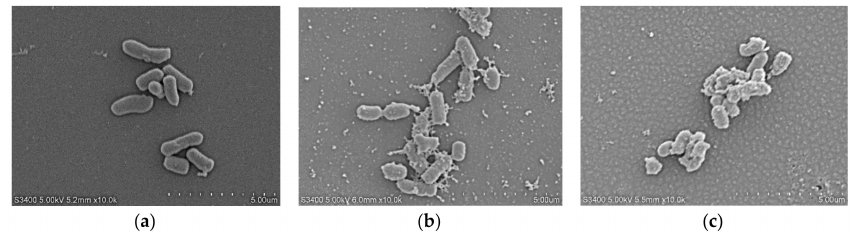
Figure 6. SEM micrographs of E. coli ATCC25922: ( a ) control; ( b ) LR pG -treated; ( c ) LR α -treated.